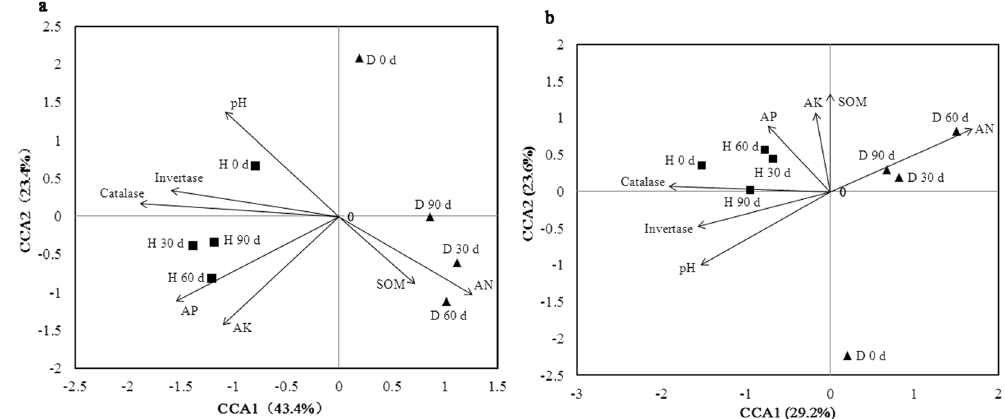
Figure 4. Canonical correspondence analysis of the relationship between microbial community structure and soil properties. ( a ) soil bacterial community; ( b ) soil fungal community. The soil properties are indicated with arrows, including soil pH, invertase, catalase, soil organic matter (SOM), available potassium (AK), nitrogen (AN), and phosphorous (AP) content. H: healthy soils; D: Bacterial wilt infected soils. The percentage of variation is explained by each